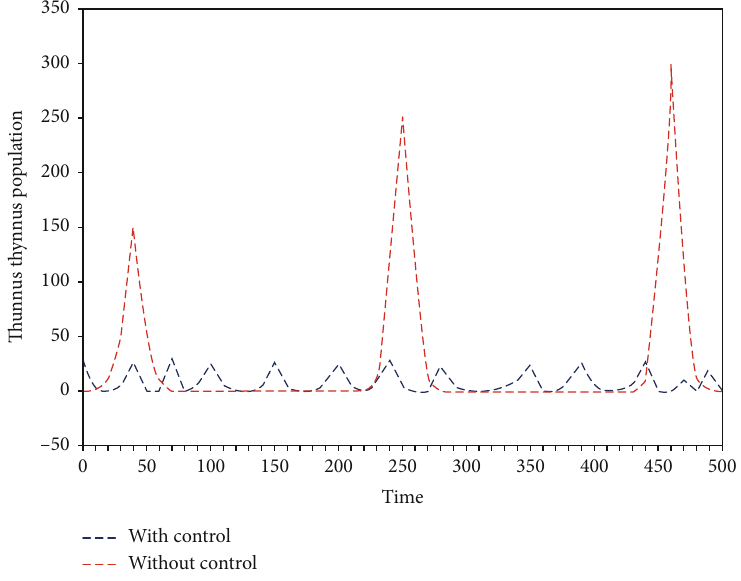
Figure 9: Thunnus thynnus population with optimal harvesting and e ff ort harvesting, with very low e ff